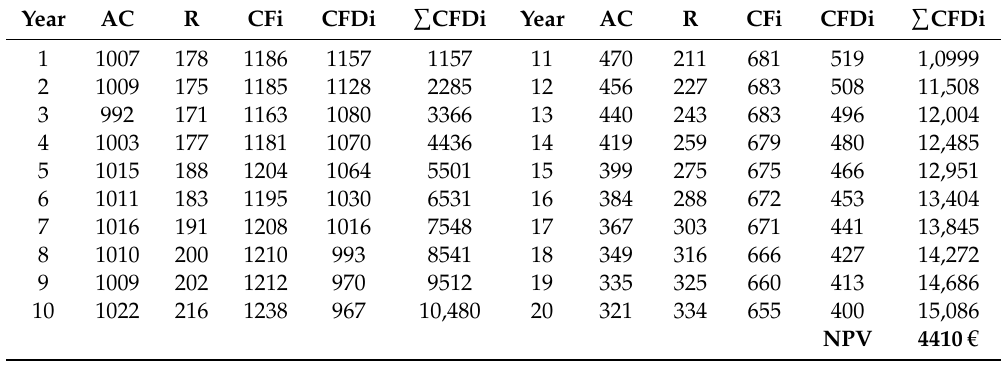
Table 14. Cash-Flow Analysis—Location 2, PV plant with Battery (cost investment, C 0 = 10,676 € ).